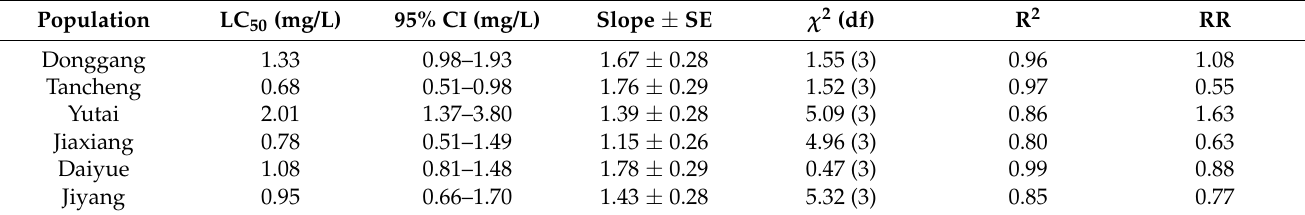
Table 7. Sensitivity to nitenpyram in six L. striatellus populations in Shandong